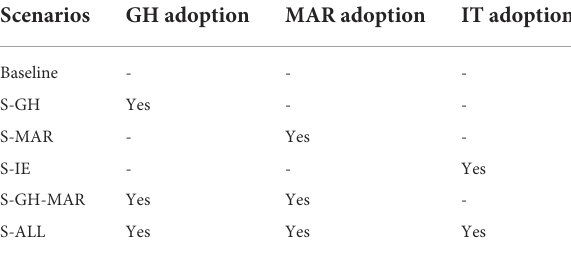
TABLE 4 Description of five scenarios on the adoption status, compared to the baseline.